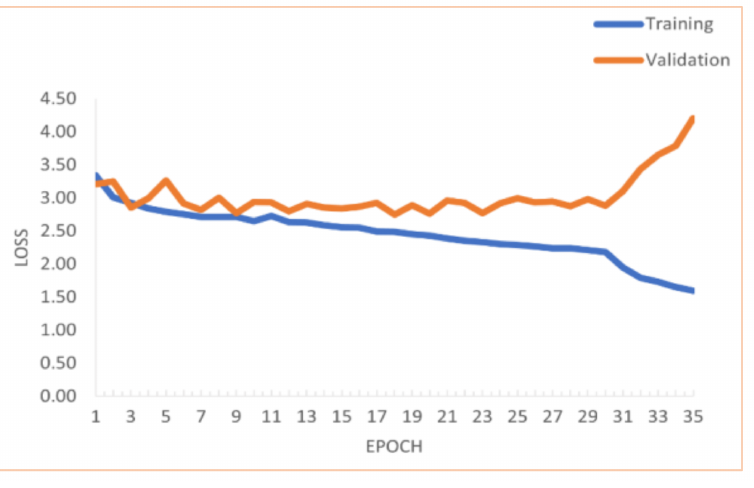
Figure 12. Graph of the cross-entropy loss results for the age estimation task.